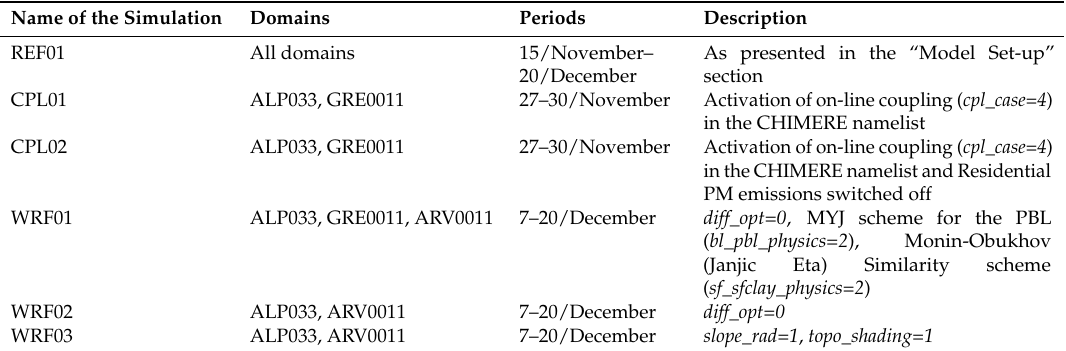
Table 5. Summary of simulations